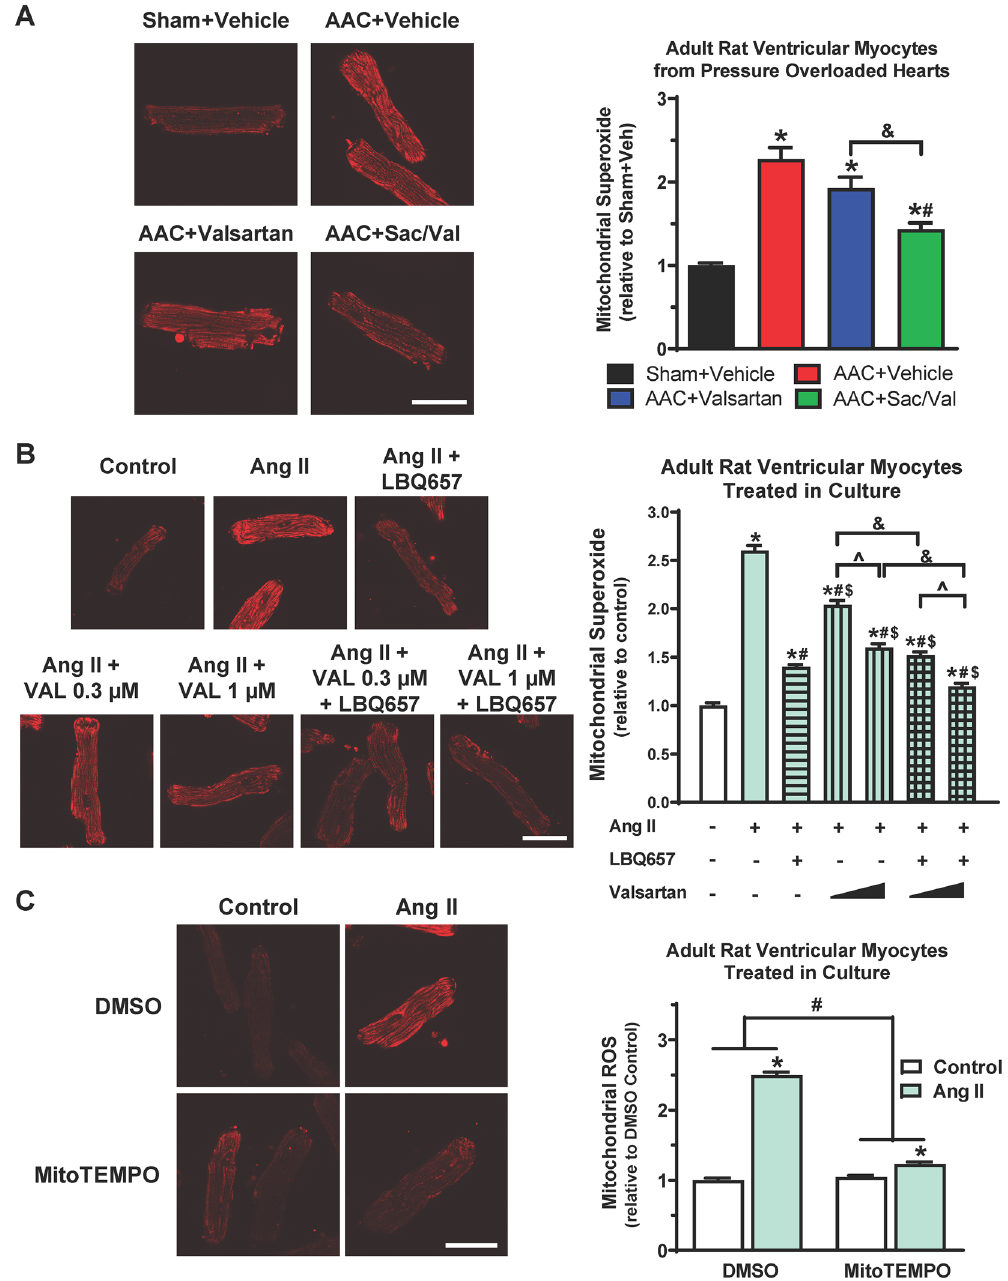
Figure 6. Sacubitril/valsartan is superior to valsartan in reducing mitochondrial superoxide in ventricular myocytes from pressure-overloaded hearts and in Ang II-treated ventricular myocytes in culture. ( A ) Cardiomyocytes isolated from pressure-overloaded hearts after 10-week treatment were stained with MitoSOX Red (5 µM, 15 min) and imaged by confocal microscope. Representative confocal images (60× magnification, scale bar: 50 µm, left ) and quantitation ( right ) of fluorescent intensities of 100–200 cells averaged for each rat as one biological sample. Mean ± SEM for N = 6–7 rats per group. Sac/Val: Sacubitril/Valsartan. * P < 0.05 versus Sham + Vehicle; # P < 0.05 versus AAC + Vehicle; & P < 0.05 for the indicated comparison. ( B ) Cardiomyocytes isolated from healthy, untreated rats and pretreated in vitro with LBQ657 (10 µM), valsartan (0.3 or 1 µM) alone or the combination of LBQ657 (10 µM) and valsartan (0.3 or 1 µM) for 1 h before Ang II stimulation (1 µM, 24 h) were stained with MitoSOX Red (5 µM, 15 min) and imaged by confocal microscope. Representative confocal images (60× magnification, scale bar: 50 µm, left ) and quantitation ( right ) of fluorescent intensities of myocytes treated in vitro. Mean ± SEM for n = 140–200 myocytes per group. * P < 0.05 versus Control. # P < 0.05 versus Ang II; $ P < 0.05 versus Ang II + LBQ657; ^ P < 0.05 Valsartan at 1 µM versus 0.3 µM; & P < 0.05 for the indicated comparison. (C) Cardiomyocytes from healthy, untreated rats were pretreated with MitoTEMPO (10 µM, 1 h) before Ang II stimulation (1 µM, 24 h), followed by MitoSOX Red (5 µM, 15 min) staining and confocal imaging. Representative confocal images (60× magnification, scale bar: 50 µm, left ) and quantitation ( right ) of fluorescent intensities of myocytes. Mean ± SEM for n = 140–200 myocytes per group. * P < 0.05 versus respective control. # P < 0.05 for the indicated